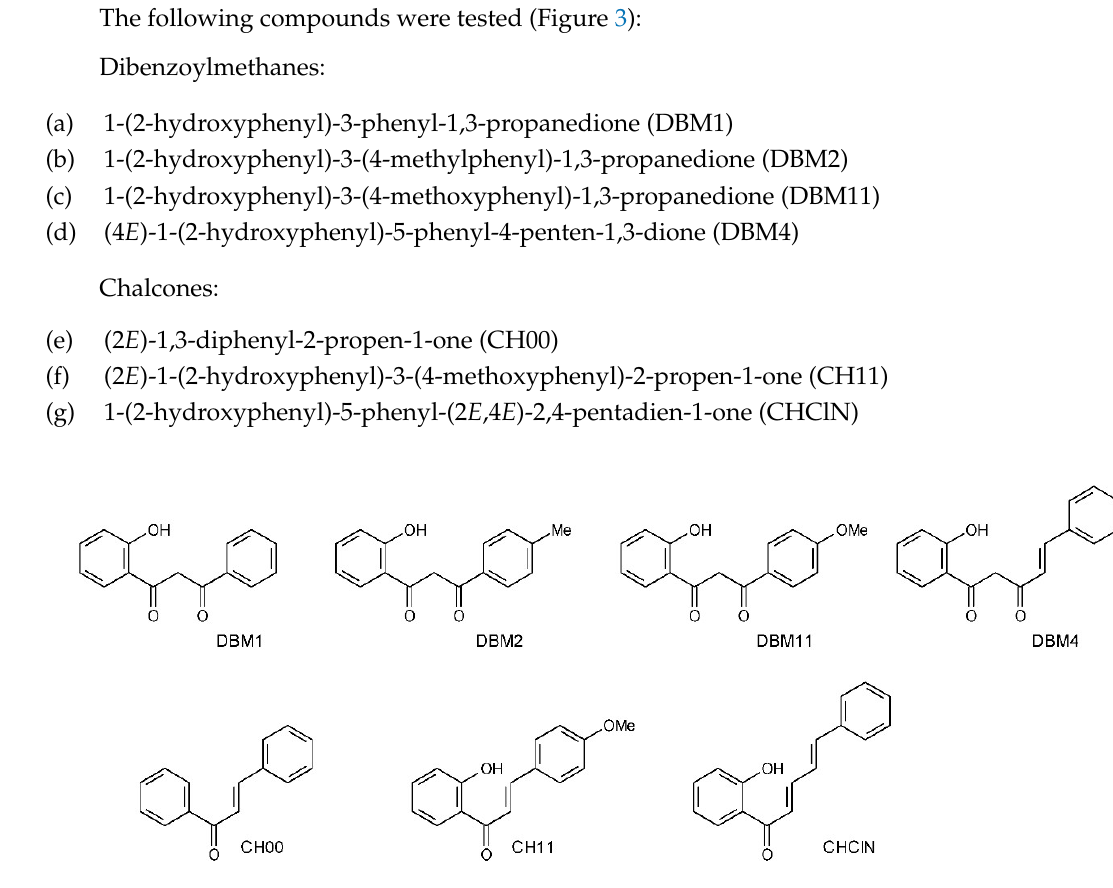
Figure 3. Dibenzoylmethanesand chalcones tested in this study.